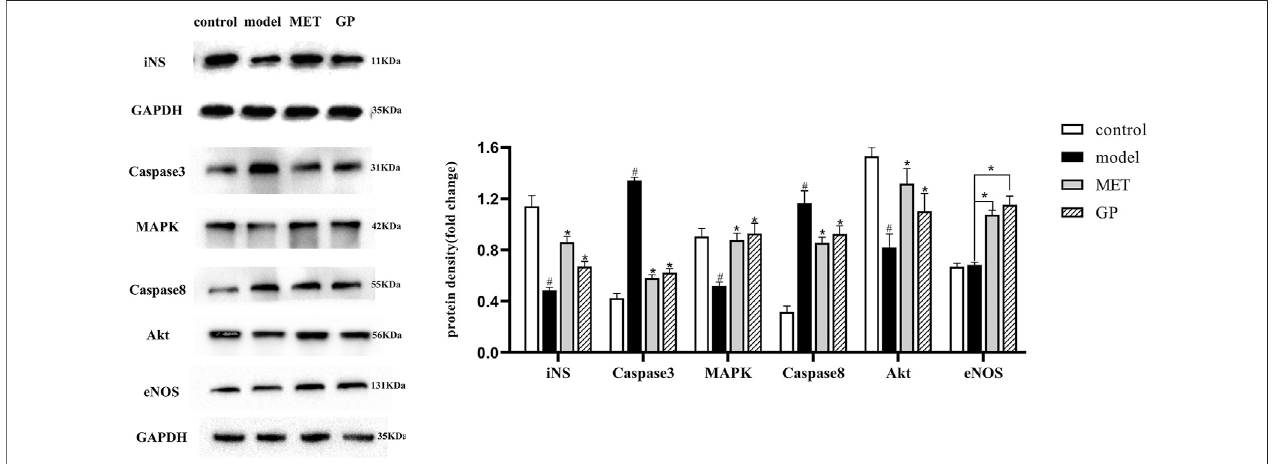
FIGURE6| EffectofGPonproteinexpressioninpancreatictissue(iNS;caspase-3;MAPK;caspase-8;Akt;andeNOS)(control;model;MET;andGP).Dataareexpressed as the mean ± SD. “ # ” represents control group vs. model group (# p < 0.05, ## p < 0.01); “ * ” represents GP group, MET group vs. the model group (* p < 0.05, ** p <